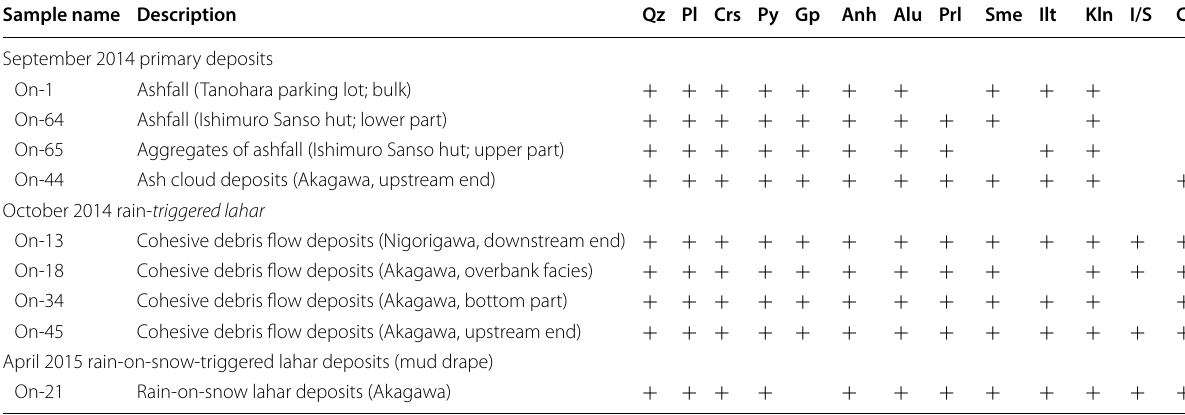
Table 2 Mineral assemblages of 2014 primary eruption, October rain‑triggered lahar, and April ROS‑triggered lahar deposits identified by XRD